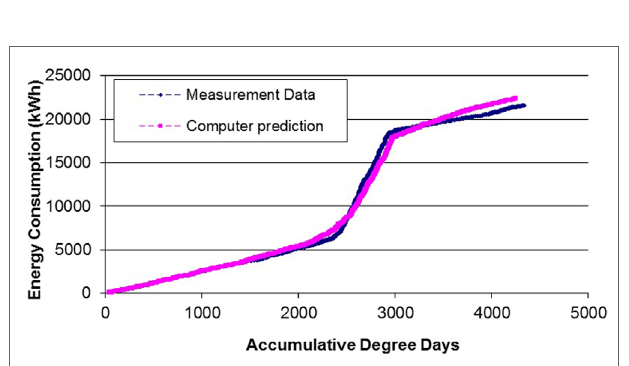
FigUre 6 | comparison on the energy consumption, computer simulation vs. measurement data .